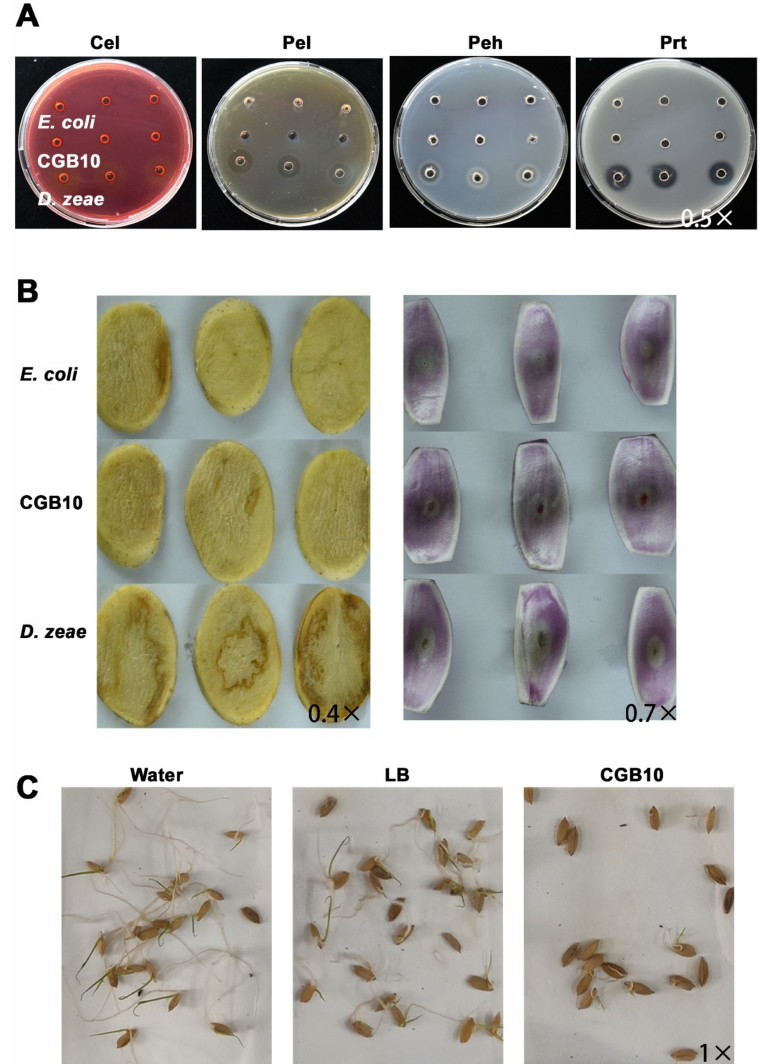
Figure 5. Pathogenicity assays of CGB10 on plants. ( A ) Plate assays of extracellular hydrolytic enzymatic activities. Cel (cellulase), Pel (pectate lyase), Peh (polygalacturonase), and Prt